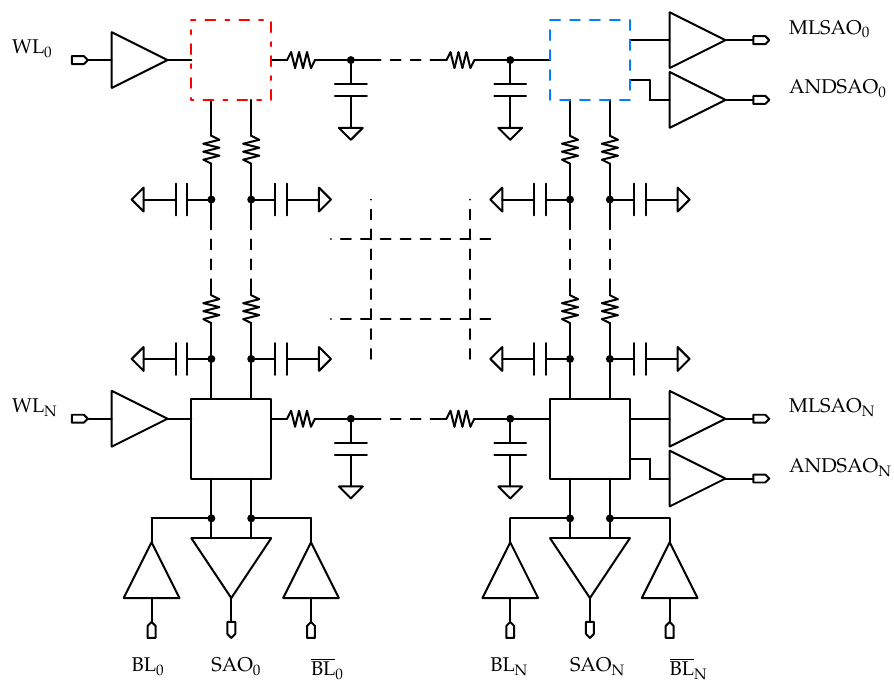
Figure 13. Worst case delays for each memory operation. Most of the memory cells are omitted for the sake of clarity, and the interconnections are represented by the RC circuits, that are substituted by the extracted rows/columns netlists in the testbench. The cell associated to the read and write operations, highlighted in blue and denoted with a dashed trait, is the farthest one from wordline and bitlines drivers, and sense amplifier; the cell associated to the worst case for the search and AND operation, highlighted in red and denoted with a dashed-and-dotted trait, is the farthest one from the MLSA and